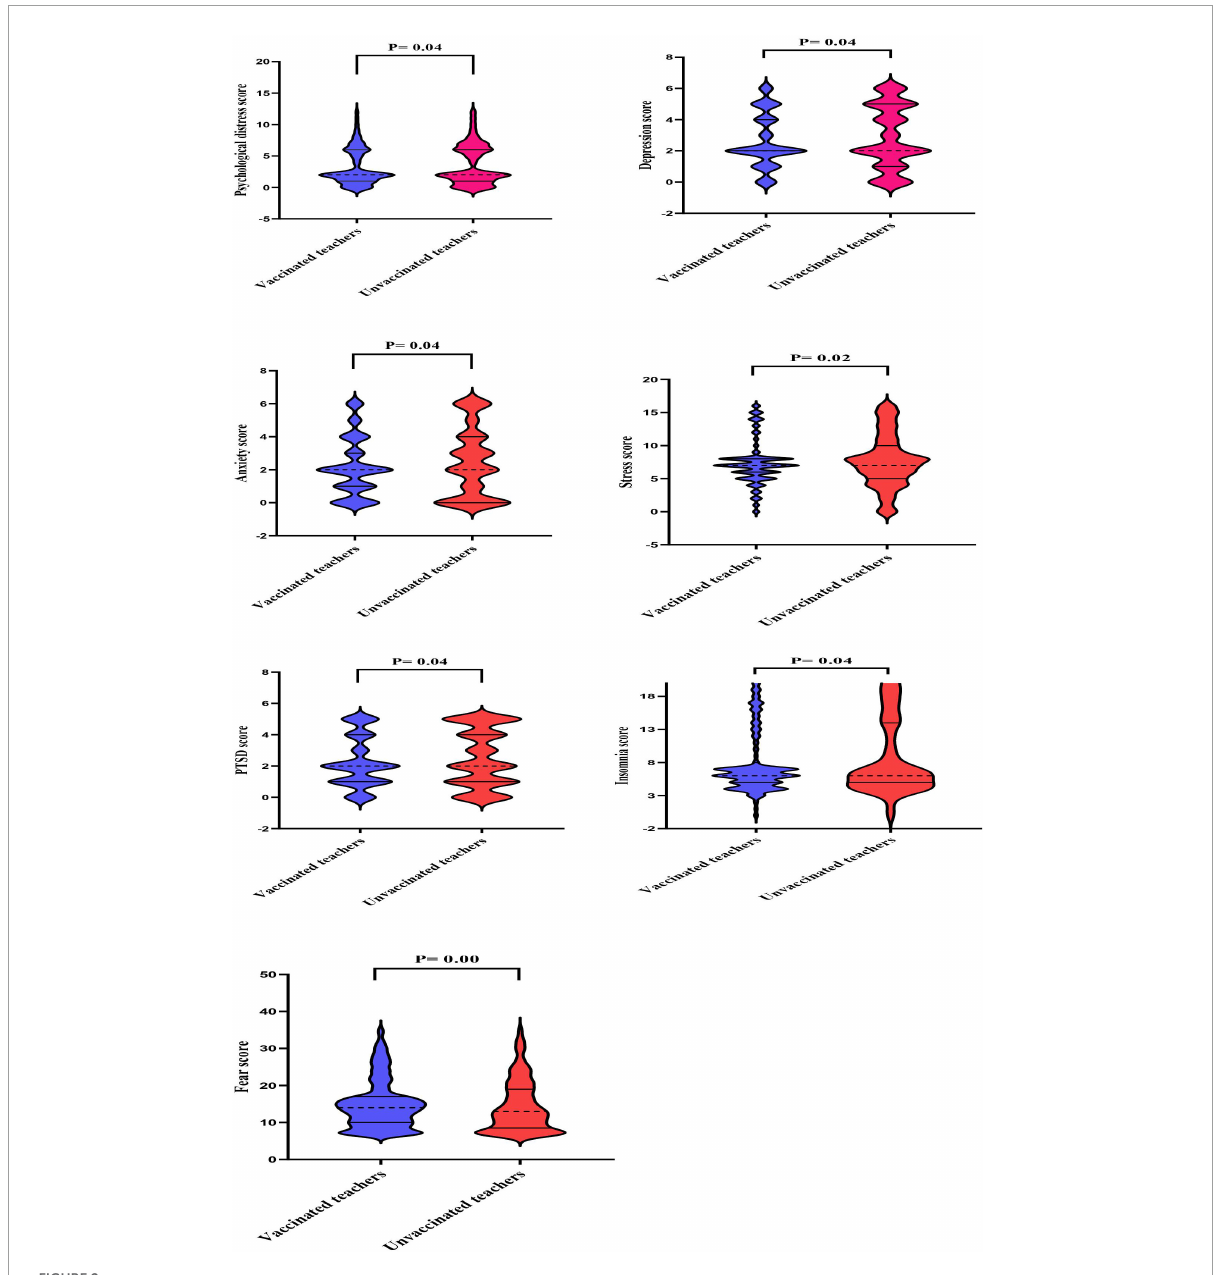
FIGURE2 The median of the interquartile range (IQR) of mental health outcome scores in vaccinated and unvaccinated teachers against COVID-19 infection. Violin plots reveal medians (dotted lines) and interquartile ranges (solid lines).